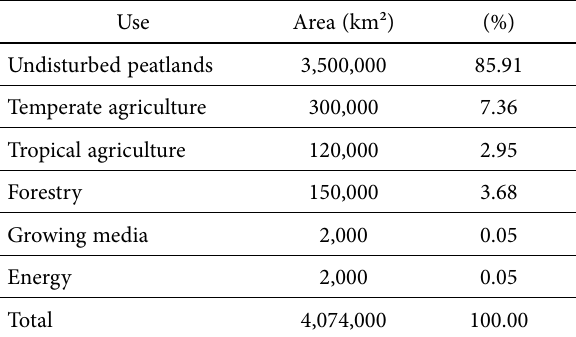
Table 2. Global area and proportions of peat(land) use according to Clarke and Rieley